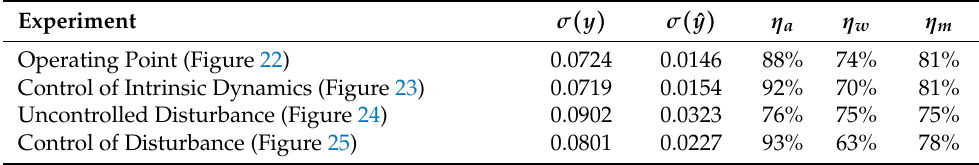
Table 1. Standard deviation of core size and efficiencies measured in the experiments of Section